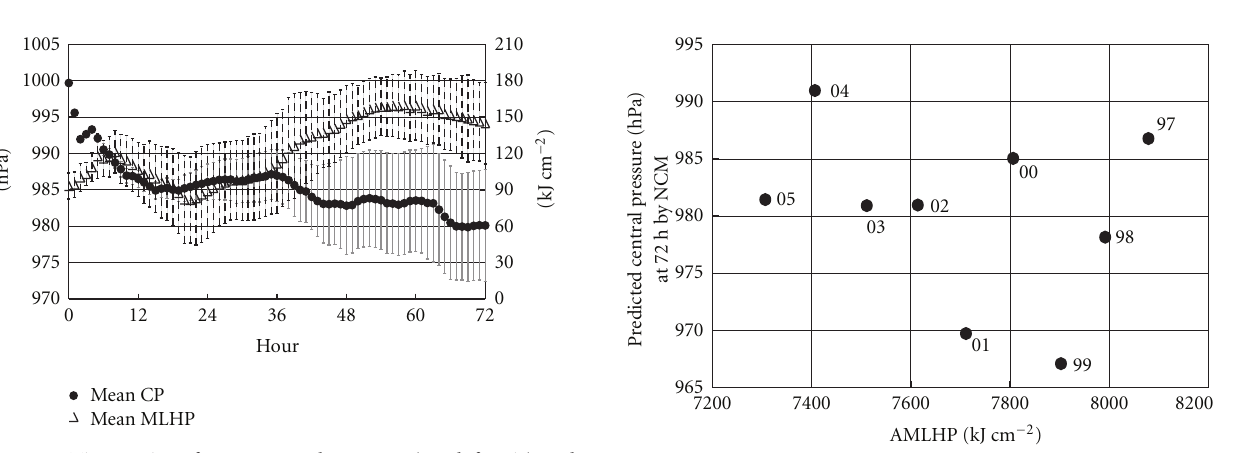
Figure 5: Time series of mean central pressure (CP, left axis) and mean mixed-layer heat potential (MLHP, right axis) predicted by NCM (averages of nine experiments) and their standard deviations.